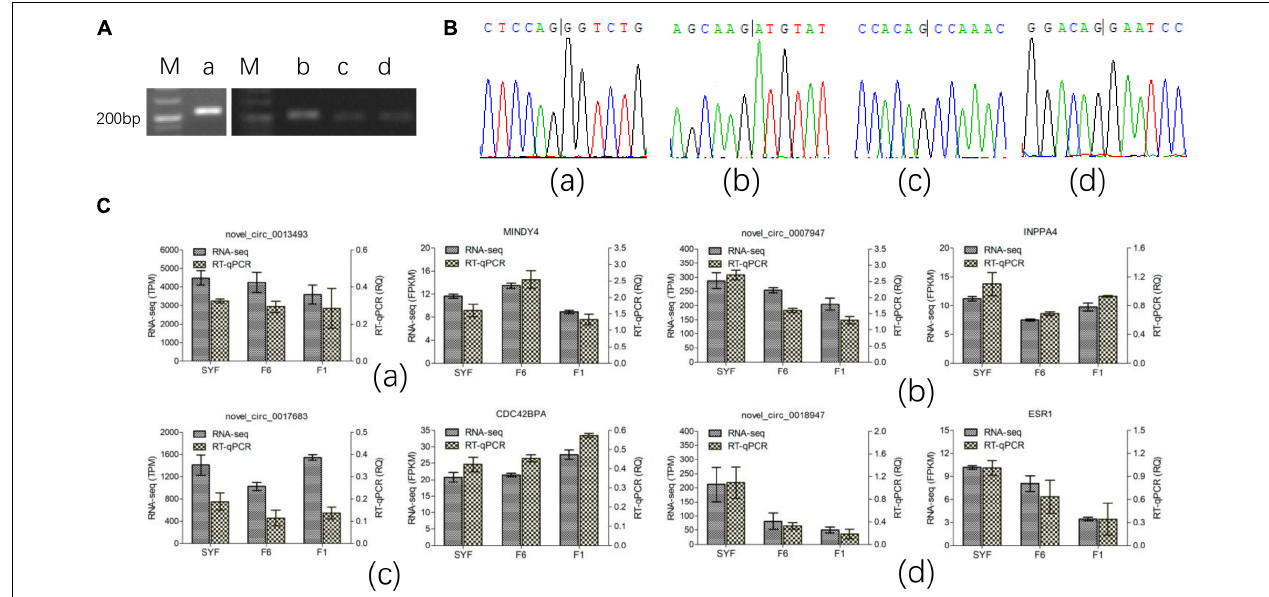
FIGURE 4 | Experimental validation of circRNA. (A) PCR products were detected in agarose gel electrophoresis; (B) Sanger sequencing for the back-splice site of circRNA circulation; (C) RT-qPCR test for the expression level. Figures of small letter a, b, c and d represents 4 circRNAs and its host genes as following